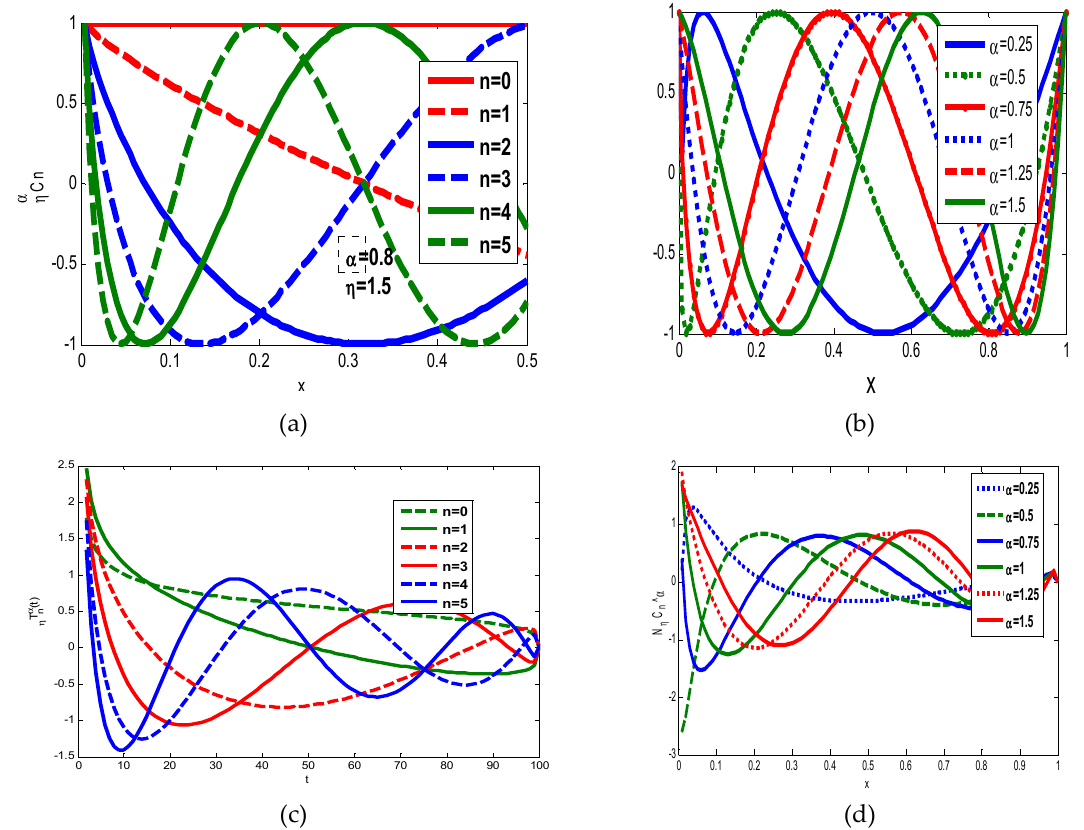
Figure 2. ( a ) Shows GFCPs different value of n = 0, 1, 2,3,4, 5 and α = 0.8, η = 1.5 . ( b ) Shows GFCPs different values of α = 0.25, 0.5,0.75, 1, 1.25,1.5 and n=5. ( c ) Normalized GFCPs different value of n = 0, 1, 2,3,4, 5 and α = 1, η = 1 . ( d ) Shows normalized GFCPs different values of α = 0.25, 0.5,0.75,1, 1.25, 1.5.